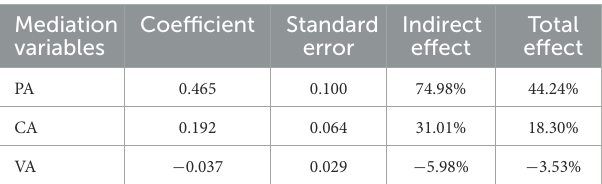
TABLE 6 Decomposition of the indirect effects of GRs on the farmers’ adoption of biosecurity